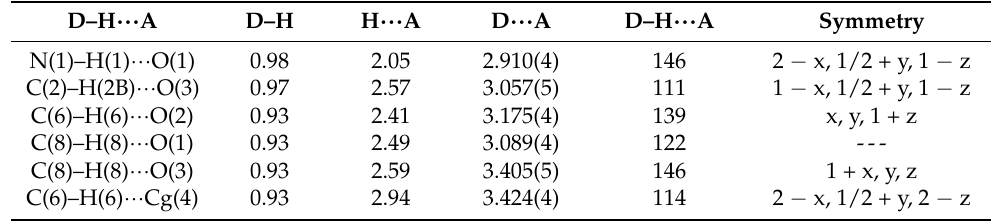
Table 2. Relevant Hydrogen Bonding Parameters in (1).